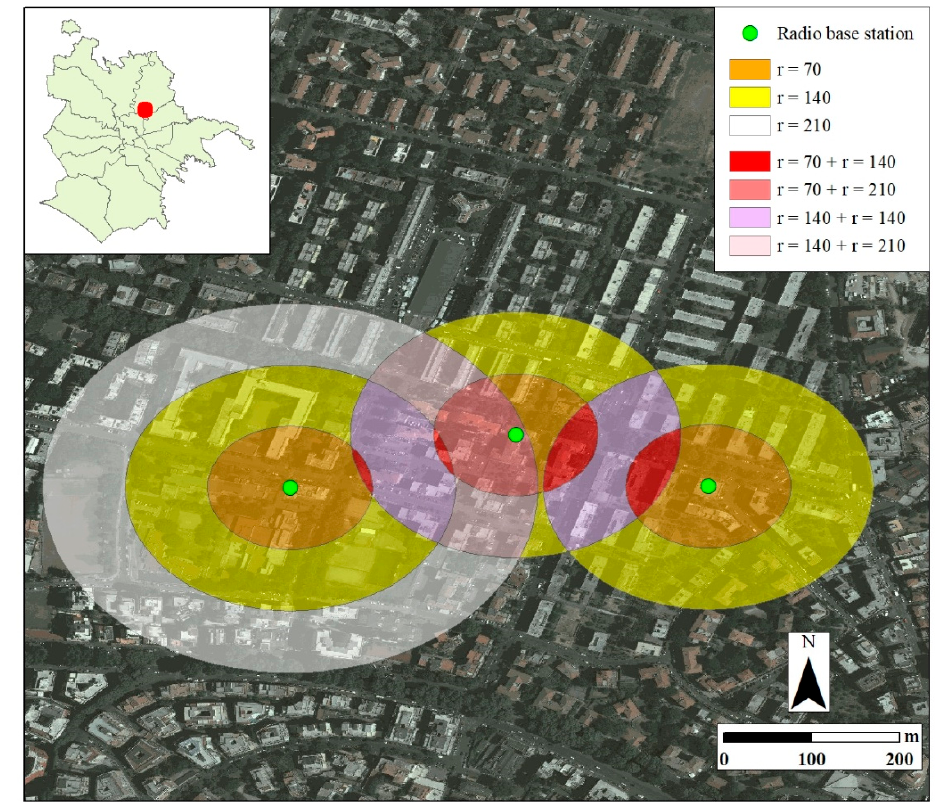
Figure 9. Circular buffer zones (in meters) defined by different radio base stations (the same as in Figure 8) in a GIS environment. Source: authors’ elaboration.